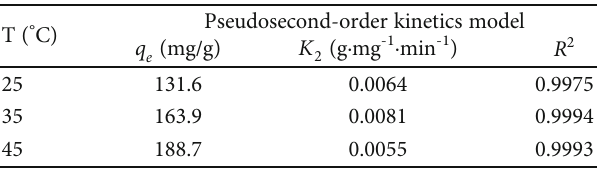
O /PANI nanocomposite at di ff erent temperatures: (A) 25 ° C, 2 4 Table 2: Kinetic parameters for uranium adsorption by CuFe O /PANI 2 4